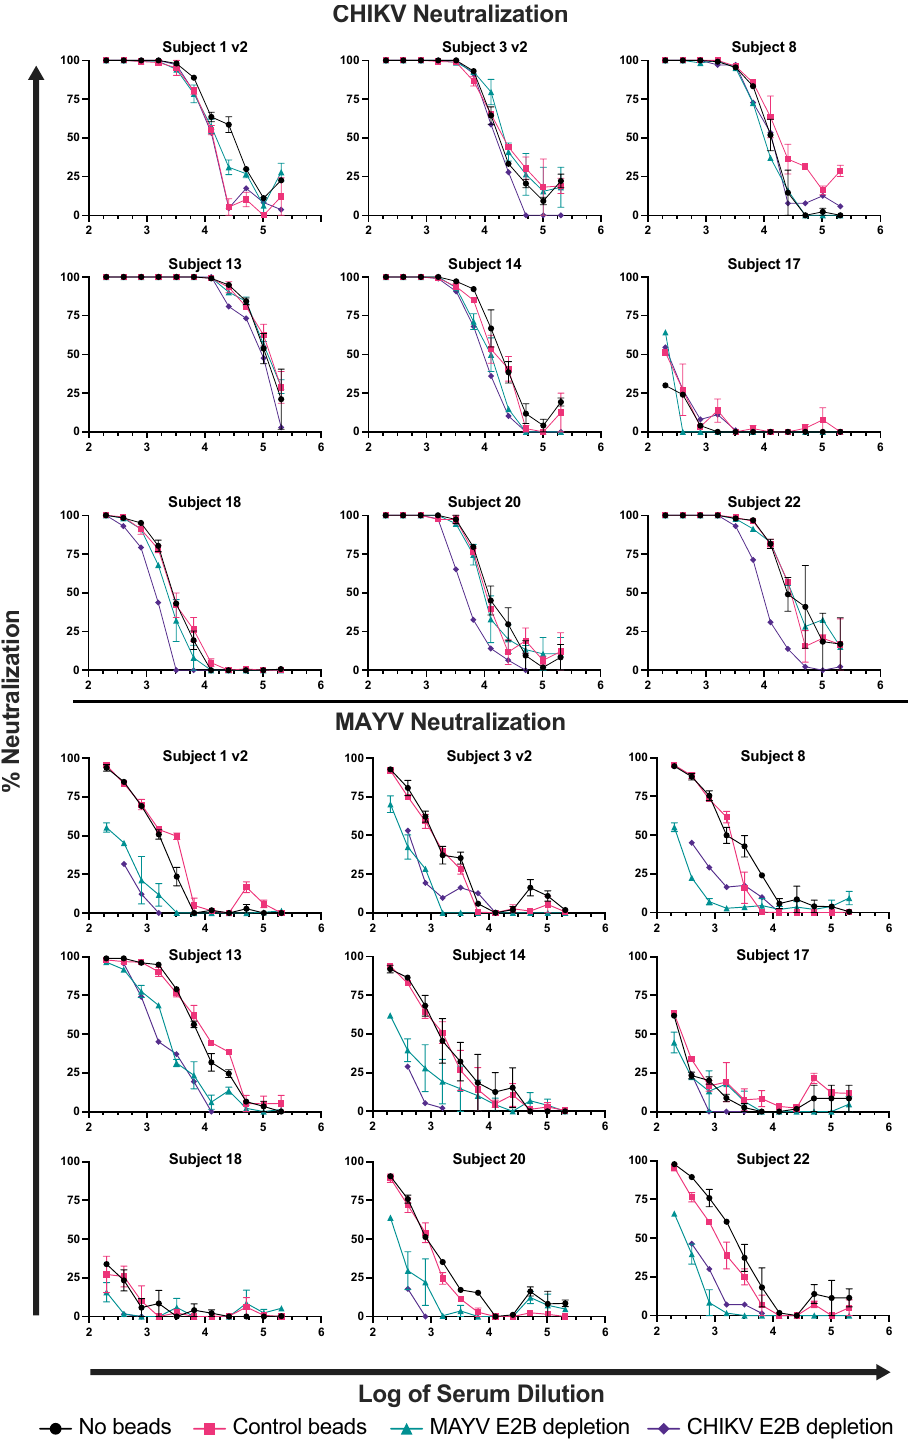
Fig 4. Impact of depletion of E2B-binding antibodies on CHIKV and MAYV neutralization. His-tagged CHIKV or MAYV E2 B domain bound to magnetic beads (or control beads alone) was adsorbed by diluted human serum for 4 hours and the beads were pulled off with a magnet. Following depletion, the sera was used in both CHIKV and MAYV neutralization assays. Human sera samples from the first blood draw were diluted 1:2 from 1:100 to 1:102,400. "No beads" is diluted serum only in black, CHIKV E2B absorbed human sera is in purple, MAYV E2B absorbed